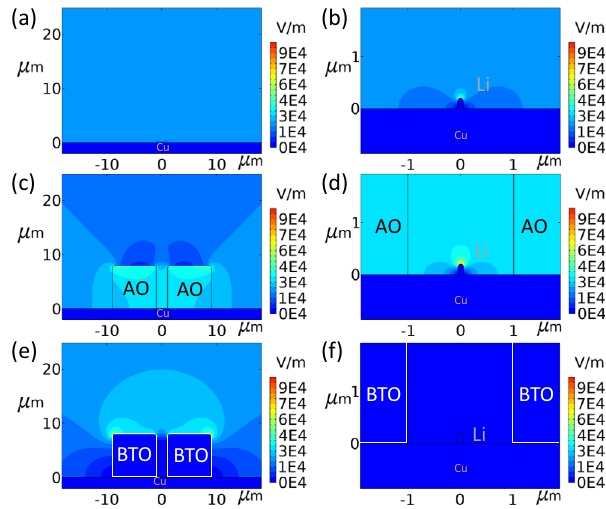
Fig. 1 Electrical fi eld simulations around a Li metal deposit with and without the presence of low and high dielectric blocks. Li metal deposit a on bare Cu planar copper and b zoomed-in fi gure, c in combination with low dielectric AO block and d zoomed-in fi gure, e in combination with high dielectric BTO block and f zoomed-in fi